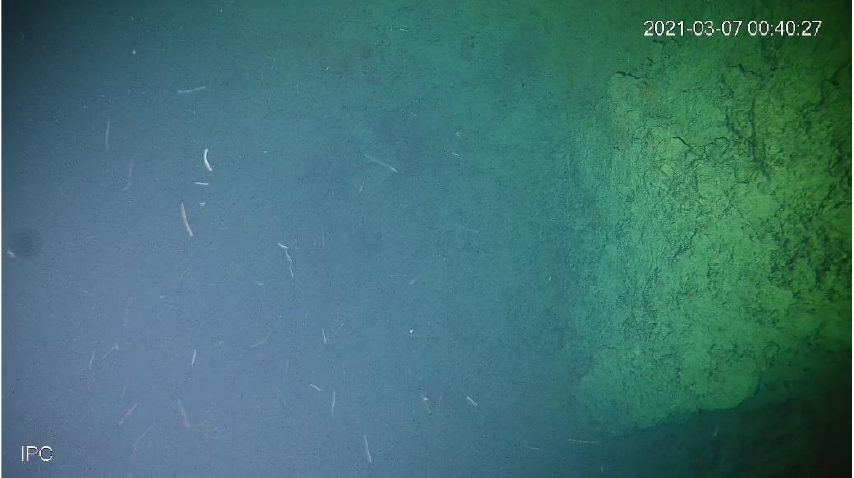
Figure 7. Screenshot of underwater the TVG camera video at 00:40 on 7 March 2021.